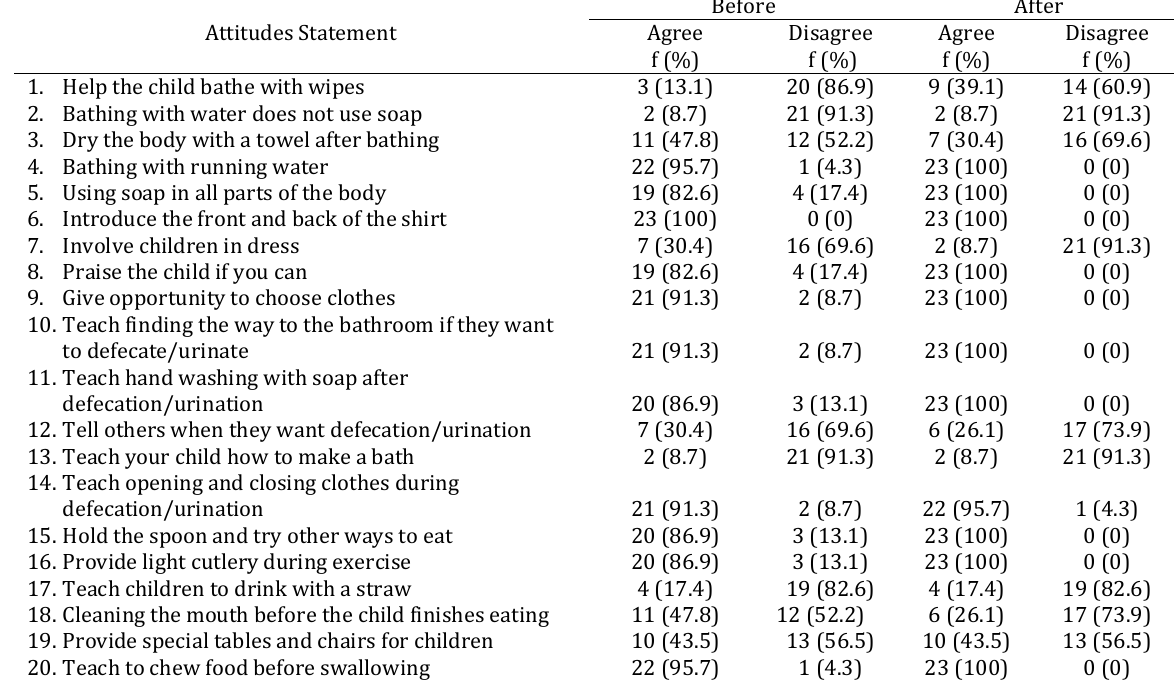
Table 5. Overview of Attitude Before and After Self-Care Training in a Physically Disabled Child's Caregiver (n= 23) Attitudes Statement